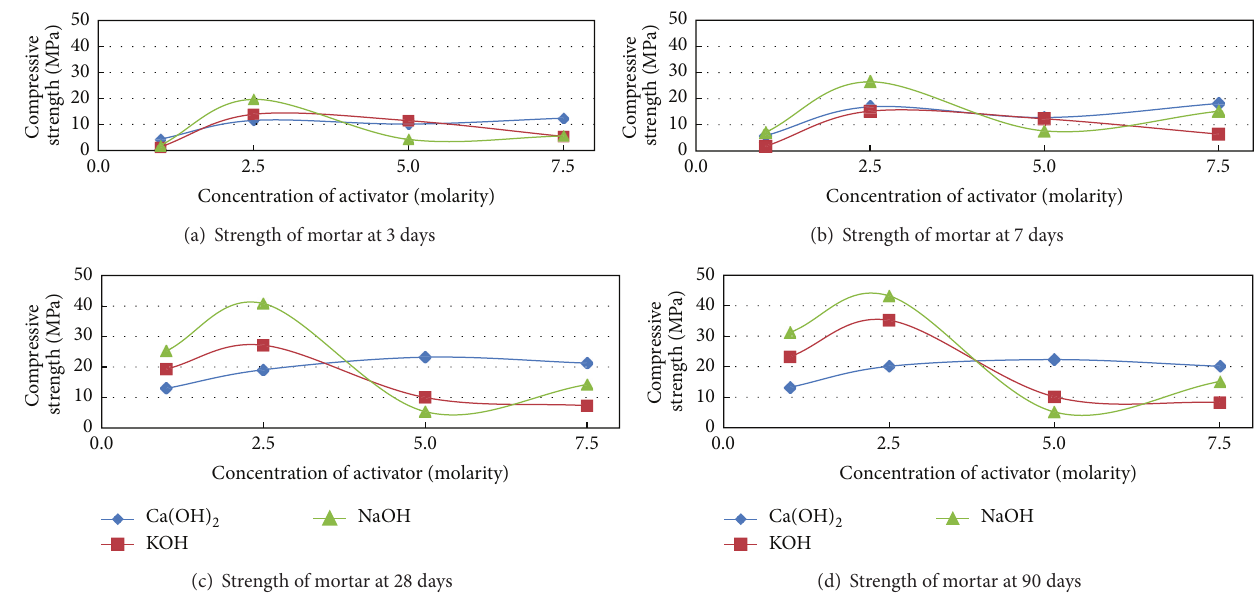
Figure 4: Strength of mortar (Z-Cem 4) for different concentrations of